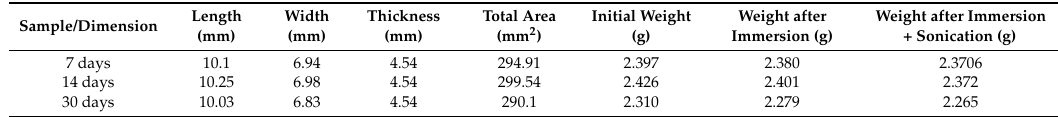
Table 2. Weight measurements after immersion in SBF 1.5% at 37 ◦